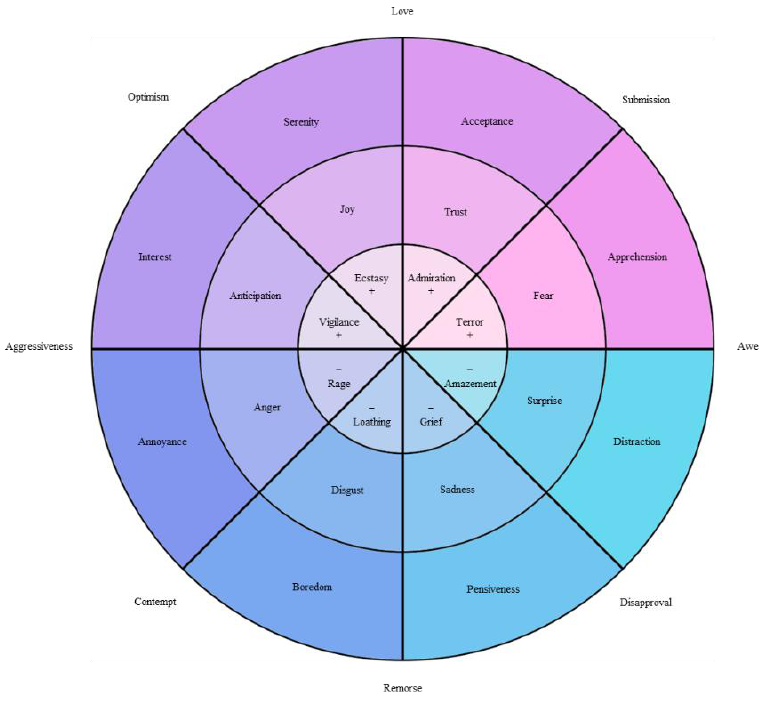
Figure 1. Emotional wheel (Revised based on Plutchik’s emotional wheel).